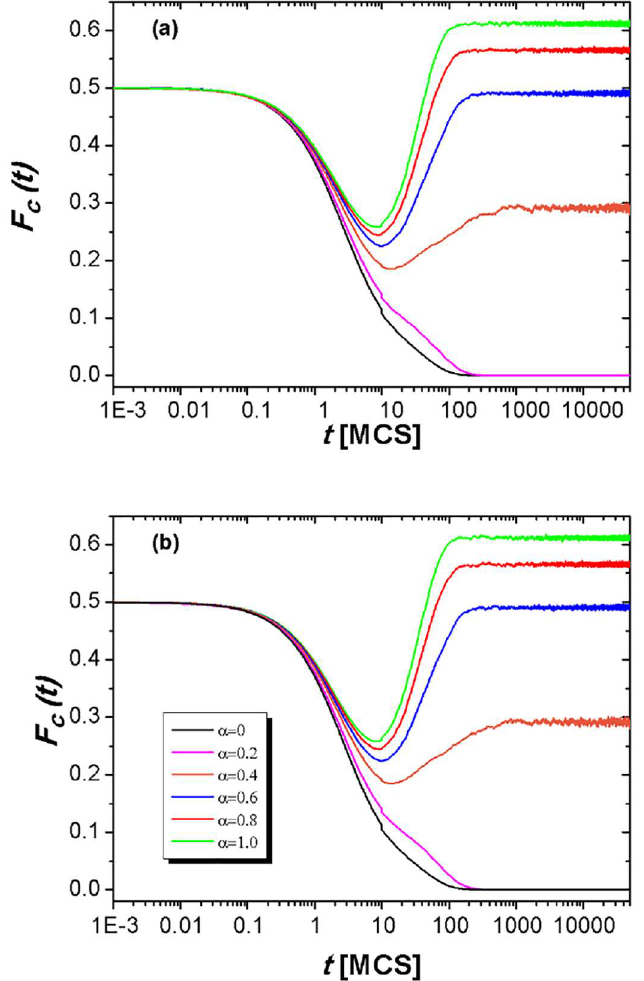
Fig 2. Fraction of cooperators [ F C ( t )] as a function of MCS time step for a fixed temptation to defect ( b = 1.07). Panel (a) and (b) characterize the evolutionof cooperation on two independentlattices, respectively. The system setup is assumed to be L = 200, MCS = 5 × 10 4 and κ = 0.1, and the tunable parameter α is set to be 0, 0.2, 0.4, 0.6, 0.8 and